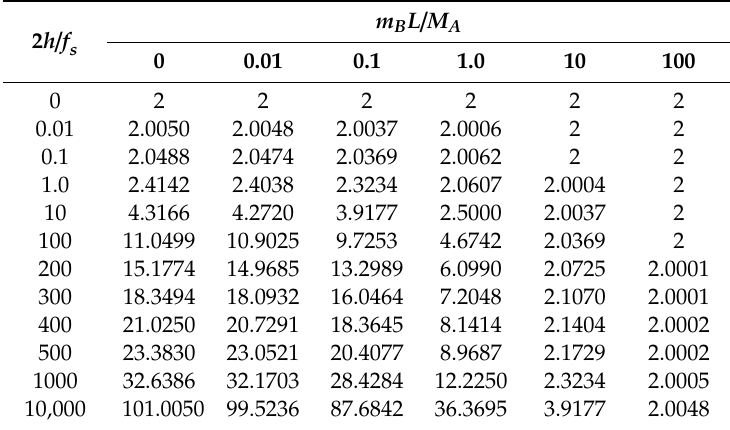
Table 3. The dynamic coe ffi cient ( k d ), depending on the ratio of the load height ( h ) to the maximum deflection ( f s ). 2 h / f s